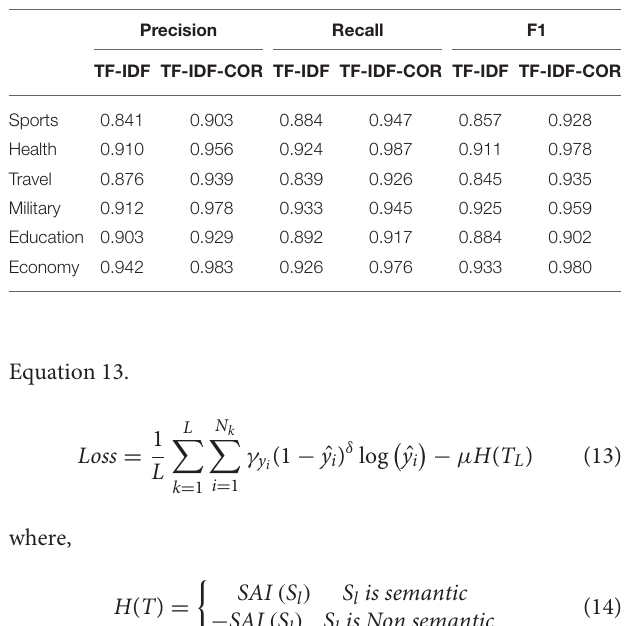
TABLE 2 | Influence of different representation learning mechanism on risk classification